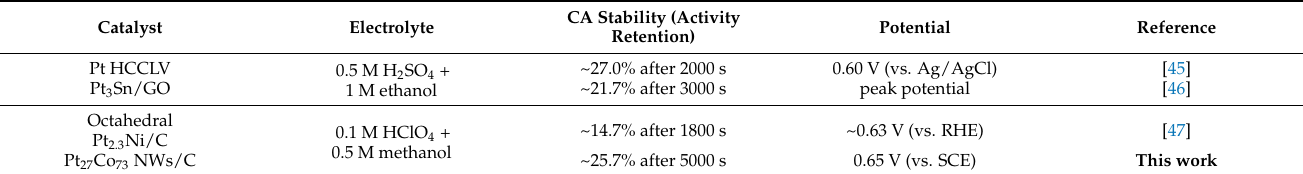
Table 3. Stability comparison of Pt 27 Co 73 NWs/C and Pt-based electrocatalysts for EOR.